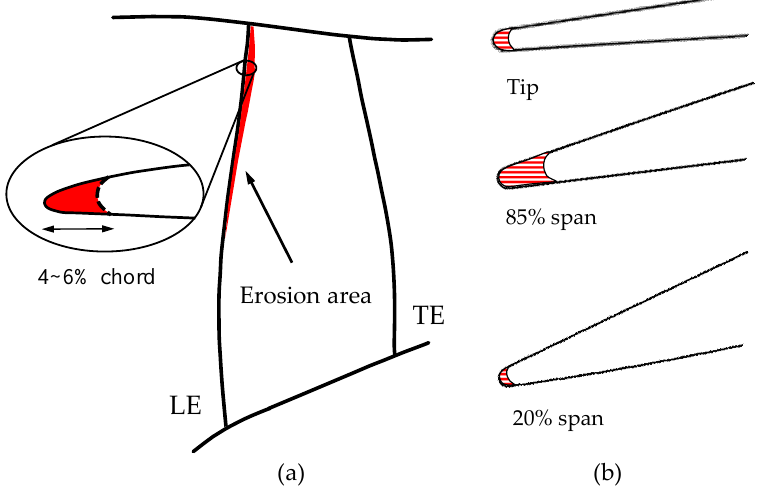
Figure 9. Schematic of erosion blades: ( a ) Erosion of chord over the outer 50% height; ( b ) degree of erosion in different blade height sections. Reproduced from [12].